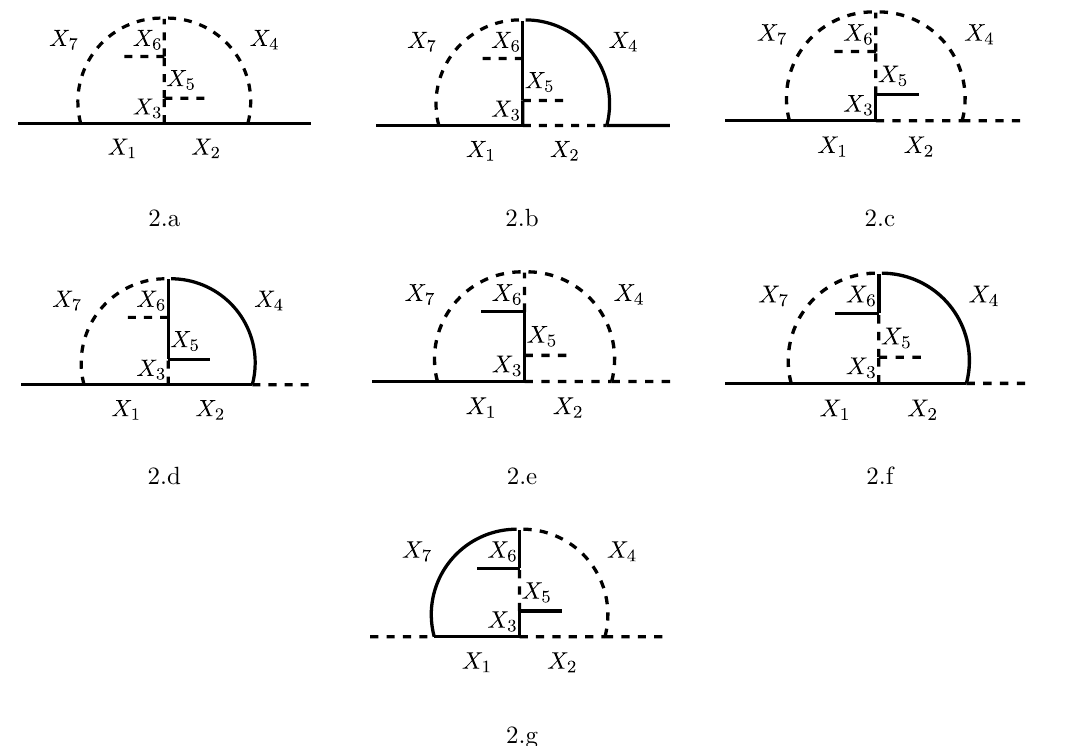
Figure 2. Two-loop diagrams for Class 2.a{2.g of Category 2.